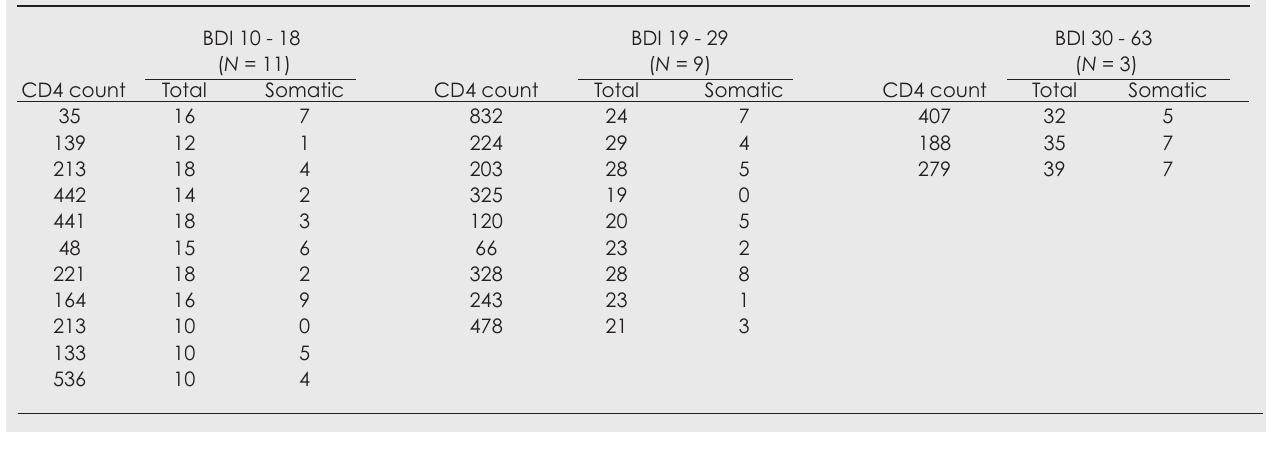
Table II. Distribution of CD4 counts versus BDI scores (somatic component) in the depressed